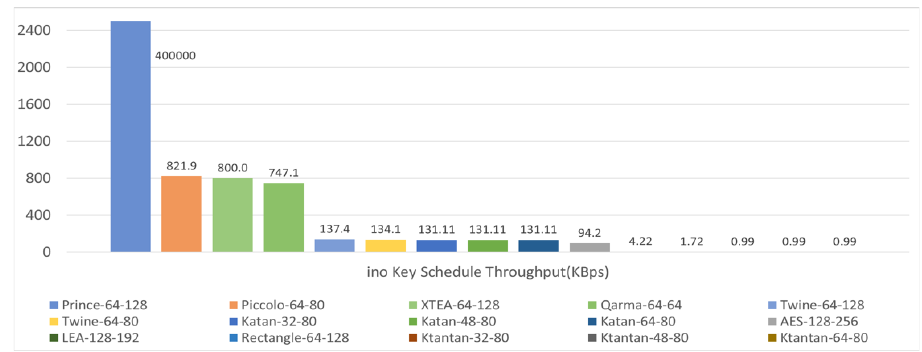
Figure 8. The 10 largest speed throughput in key schedule and 5 least in UNO.